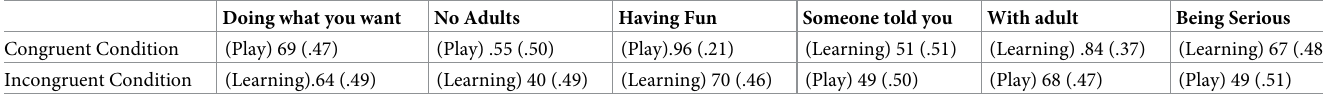
Top parentheses show which question was asked. In the congruent condition, children were asked to provide examples of times they were playing and doing what they wanted, with no adults, and having fun and examples of times they were learning when someone told them what to do, with an adult, and while being serious. In the incongruent condition, they were asked about play when someone told them what to do, with an adult, and while being serious and learning while doing what they wanted, with no adults, and while having fun. Bottom parentheses shows standard